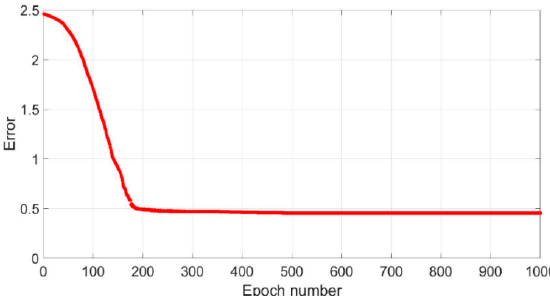
Figure 10. Training process.